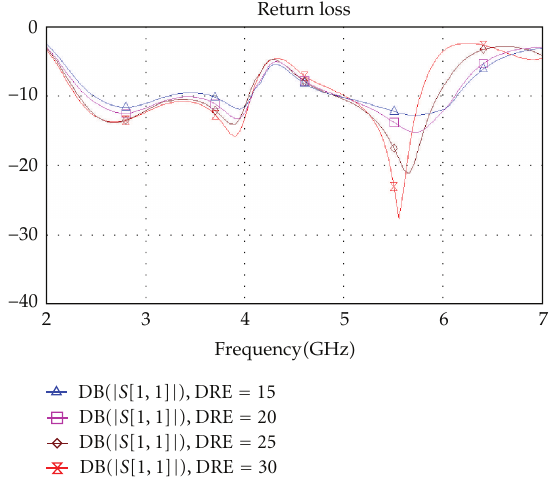
Figure 5: Simulation return loss of hybrid DR antenna with di ff erent rectangular patch